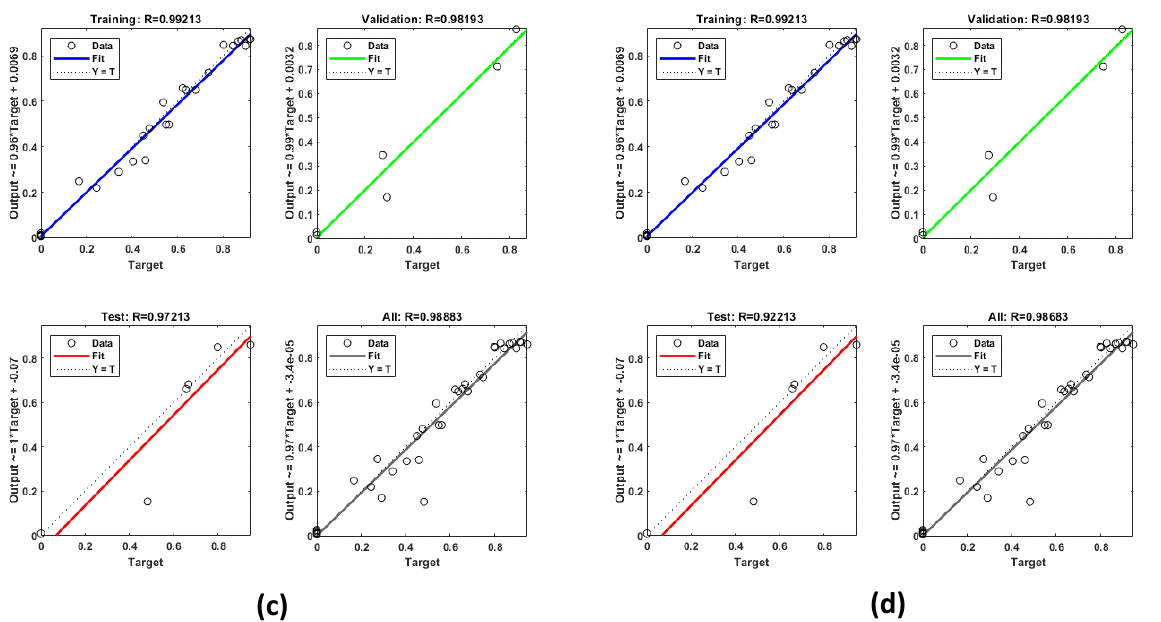
Figure 6. Regression model D T , ( a ) porosity-based D T under slow cooling, ( b ) elasticity-based D T under slow cooling, ( c ) porosity-based D T under rapid cooling, and ( d ) elasticity-based D T under rapid cooling.